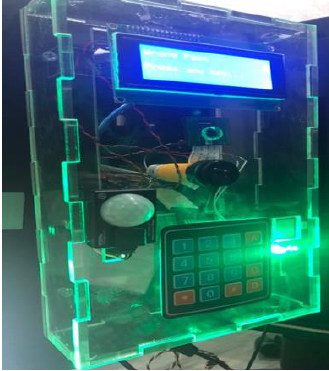
Figure 4. A Green color is turned on when a correct password is entered.